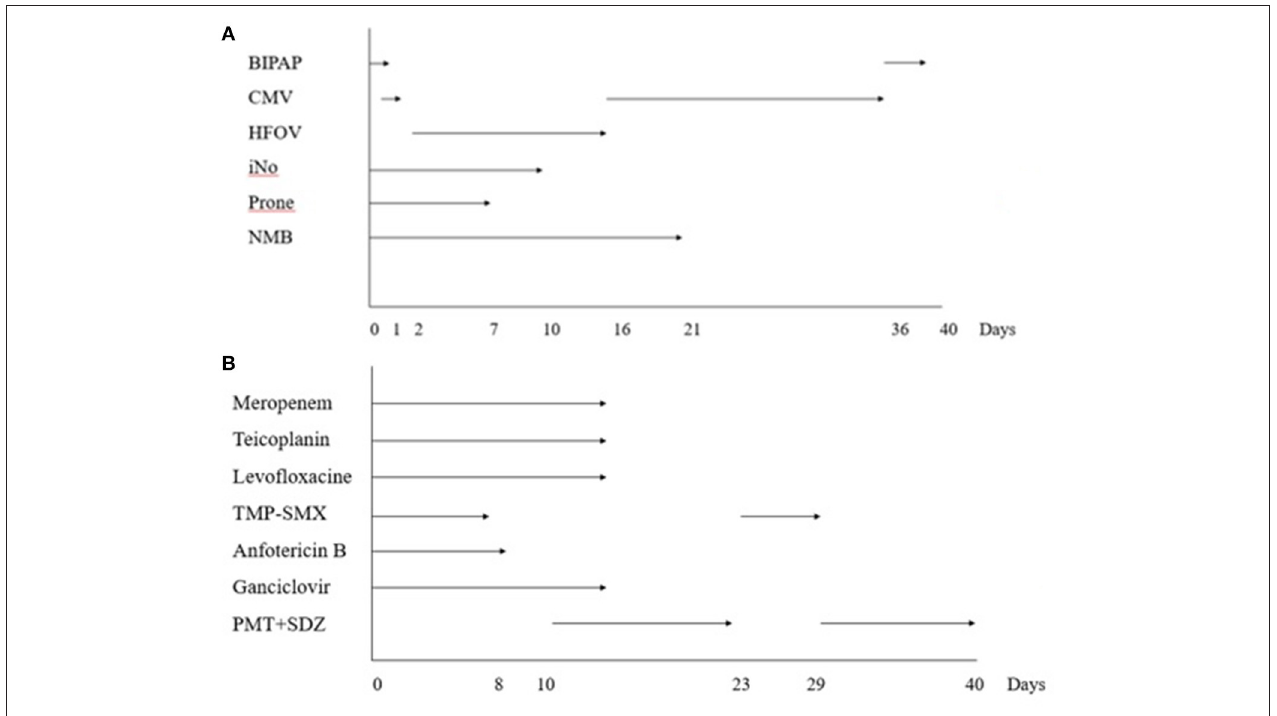
FIGURE 2 | (A) Ventilatory support diagram. CMV, conventional mechanical ventilation; HFOV, high flow oscillatory ventilation; iNO, inhaled nitric oxide; NMB, neuromuscular blockade. (B) Anti-infectious treatment diagram. TMS-SMX, trimethoprim-sulfamethoxazole; PMT + SDZ, pyrimethamine +